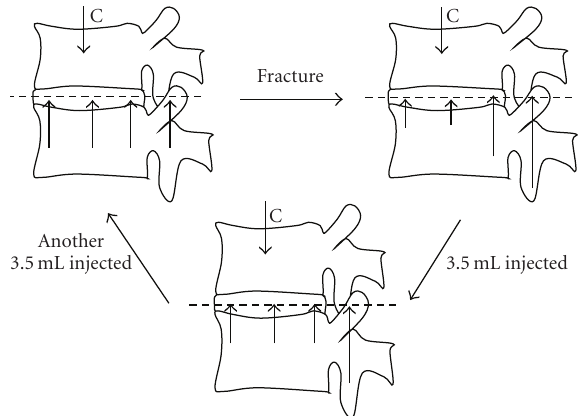
Figure 3: Diagram summarising the changes in load bearing by vertebrae following fracture and vertebroplasty. The length of the upward pointing arrows represents load bearing by di ff erent regions of the vertebra. Before fracture (A), the compressive load is borne mostly by the anterior column (disc and vertebral bodies) and stress is distributed evenly across the disc and adjacent vertebral bodies. After fracture (B), stress falls in central and anterior regions of the disc and increases in the posterior annulus and neural arch. Injecting 3.5ml of cement into the fractured vertebral body (C) causes stress to be distributed more evenly across the disc, but loading on the neural arch remains elevated. Injecting a further 3.5ml of cement restores neural arch load bearing towards pre- fracture levels (A). Based on data from Luo et al.